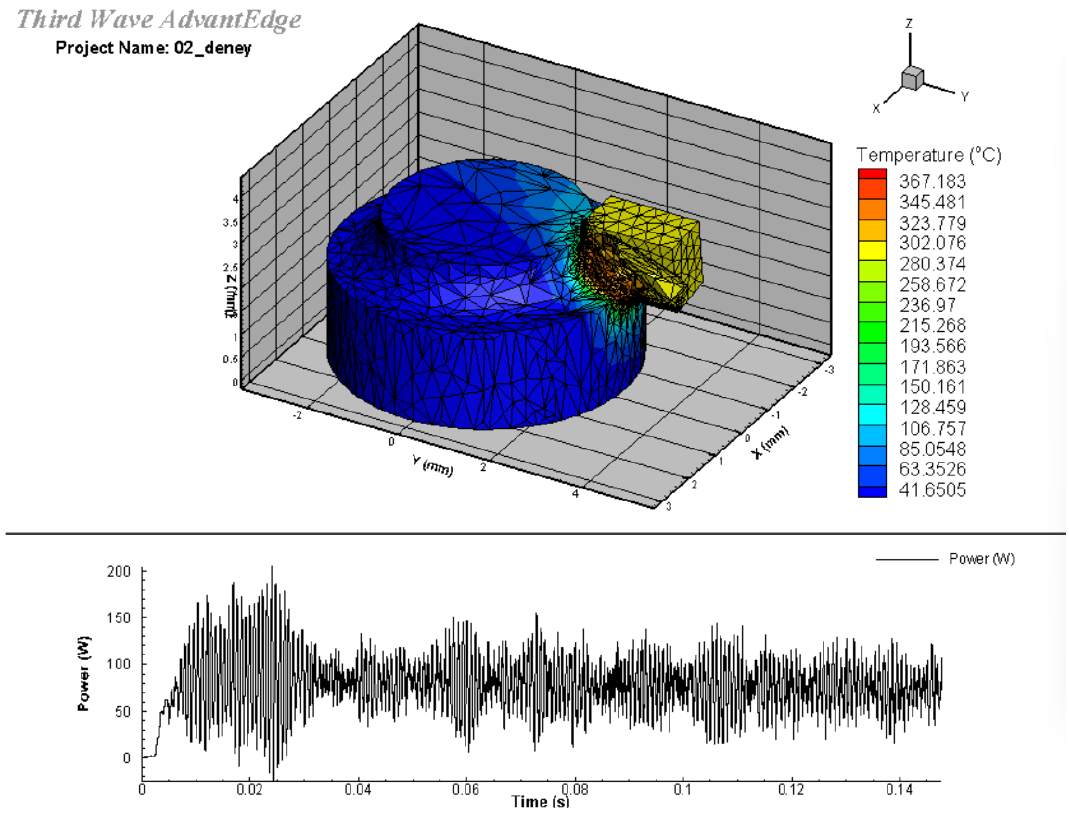
Figure 5. The analysis results for experiment no. 9.